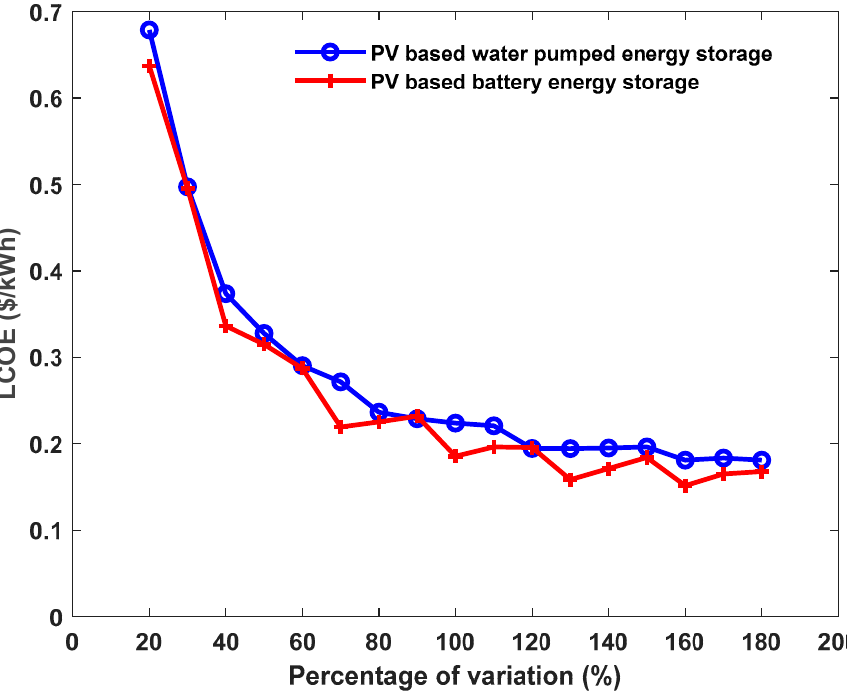
Figure 16. Influence of the variation of the project lifetime on the COE of the studied systems.